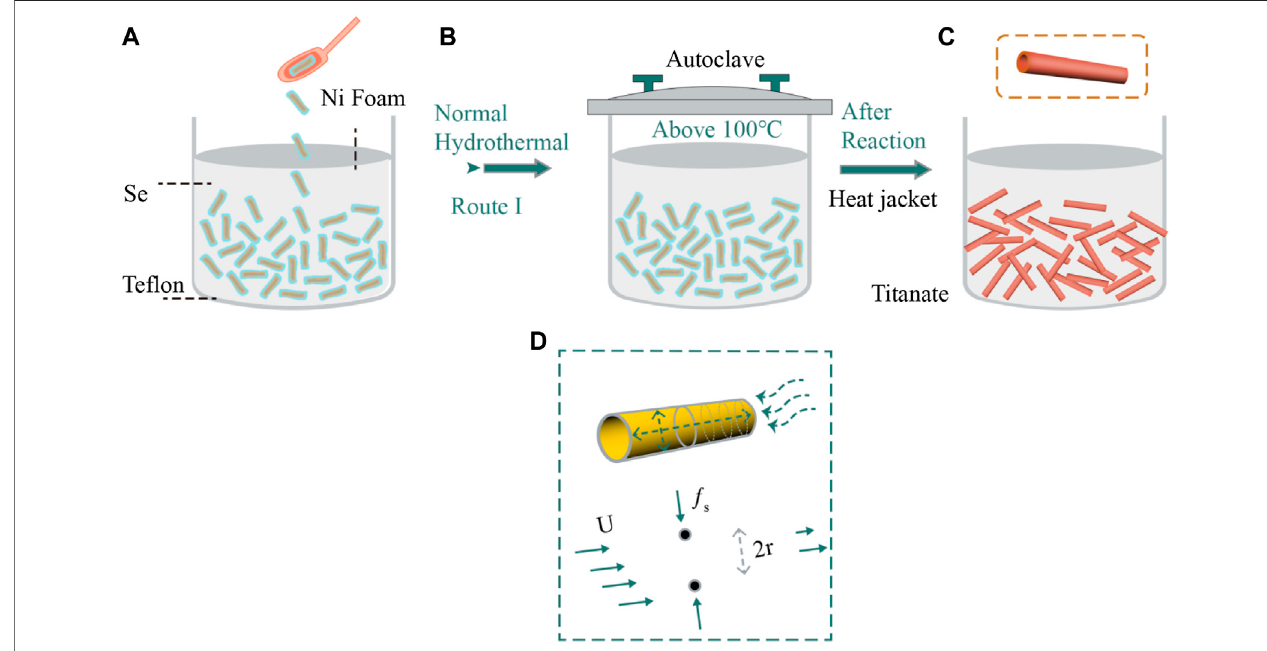
FIGURE 4 | schematic diagram of typical hydrothermal method